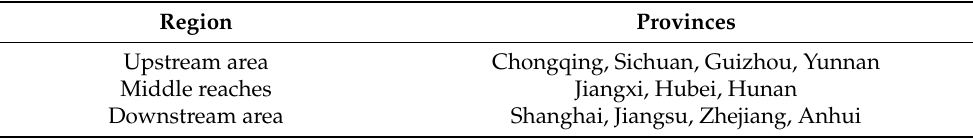
Table 1. Regional division of the upper, middle, and lower reaches of Yangtze River Economic Belt. Region Provinces Upstream area Middle reaches Downstream